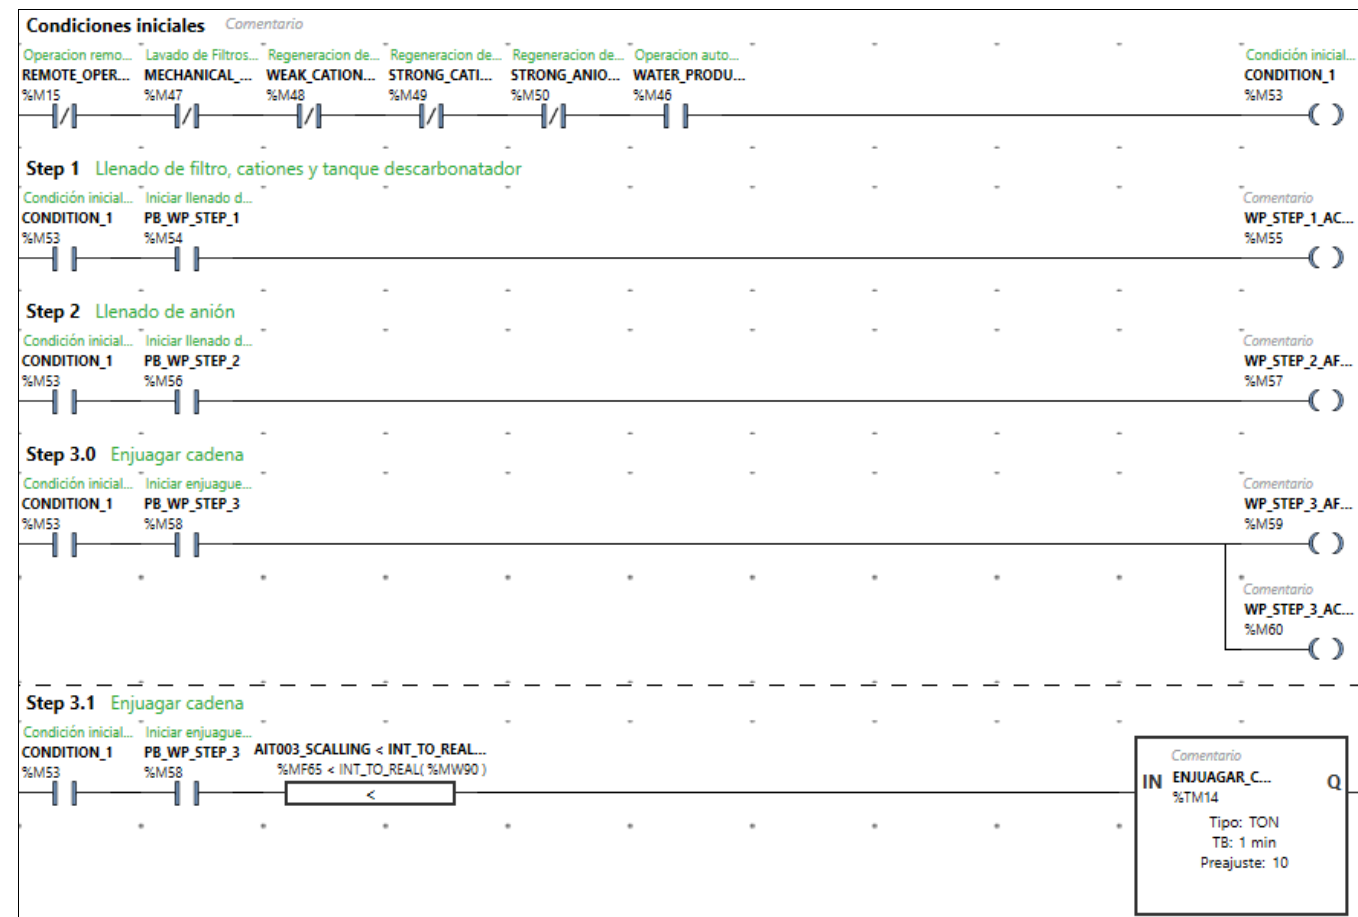
Figure 3: Fragment of the PLC M221CE24R programming using EcoStruxure Machine Expert Basic software. Source: Authors,